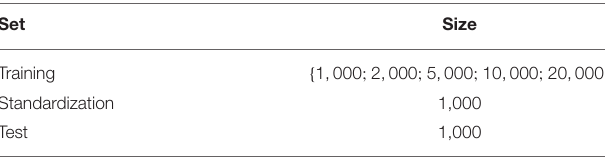
TABLE 2 | Size (number of individuals) of training, standardization, and test sets for assessing predictive power on real data. Set